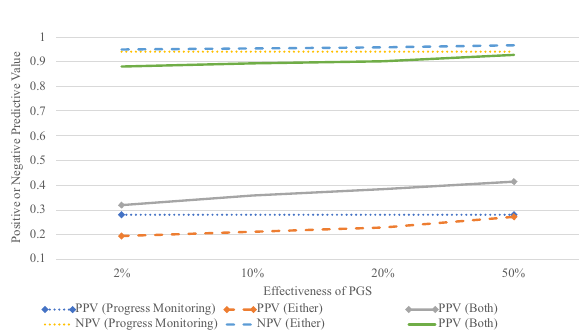
Fig. 1 Trends in positive and negative predictive values of using PGS and progress monitoring as a screener for learning disabilities (tenth percentile cutoff) at varying levels of PGS effectiveness. This table represents when progress monitoring is correlated with end-of-year achievement at r = 0.55. PPV positive predictive value, NPV negative predictive